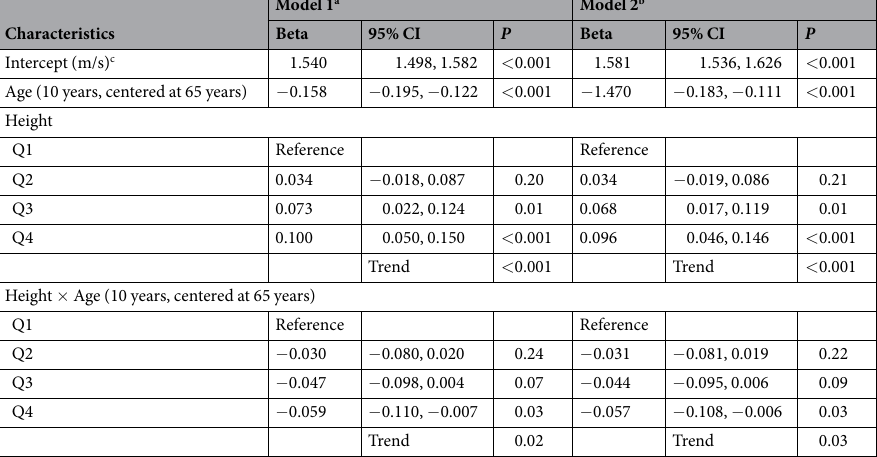
Table 2. Cross-Sectional Association of Height With Fast Gait Speed at Study Baseline (1999–2001) (N = 3,707). Beta, regression coefficients; CI, confidence interval; Q1 (shortest)-Q4 (tallest), sex-specific quartiles of height; BMI, body mass index; MMSE, mini-mental state examination. Please see the supplementary methods for the equations corresponding to the models presented in the table. a Adjusted for sex (reference, women), education (reference, low education), baseline BMI (reference, < 25 kg/m 2 ). b Model 1 + MMSE, history of cardiovascular disease (stroke, coronary heart disease, lower-limb arteritis), hypertension, hypercholesterolemia. c The intercept (model 1) corresponds to the average fast gait speed for women aged 65 years at baseline, with normal BMI, low education, and in the lower quartile of height. In model 2, the reference group for covariates were: highest tertile of MMSE, no cardiovascular disease, no history of hypertension, no hypercholesterolemia.